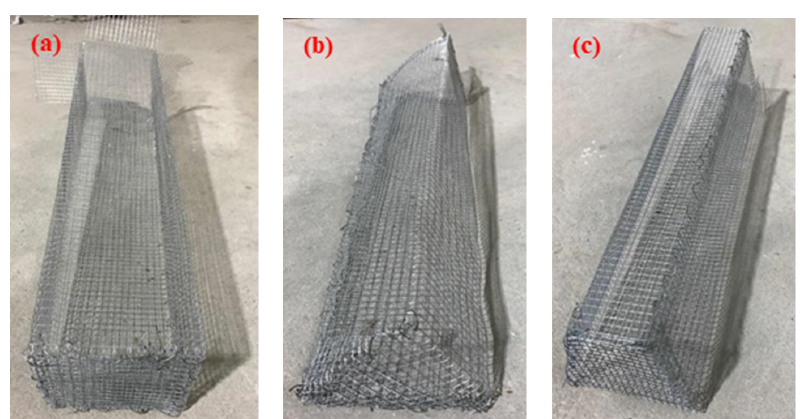
Figure 4. Alloy cages with different section shapes (( a ) rectangle; ( b ) triangle; ( c ) trapezoid).